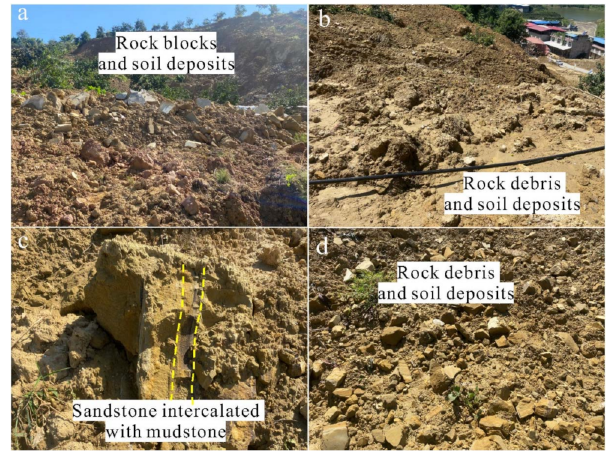
Figure 10. Accumulation features comprising soil with high gravel content. ( a , b , d ) The rock debris in the front, middle and rear respectively. ( c ) Sandstone intercalated with mudstone.